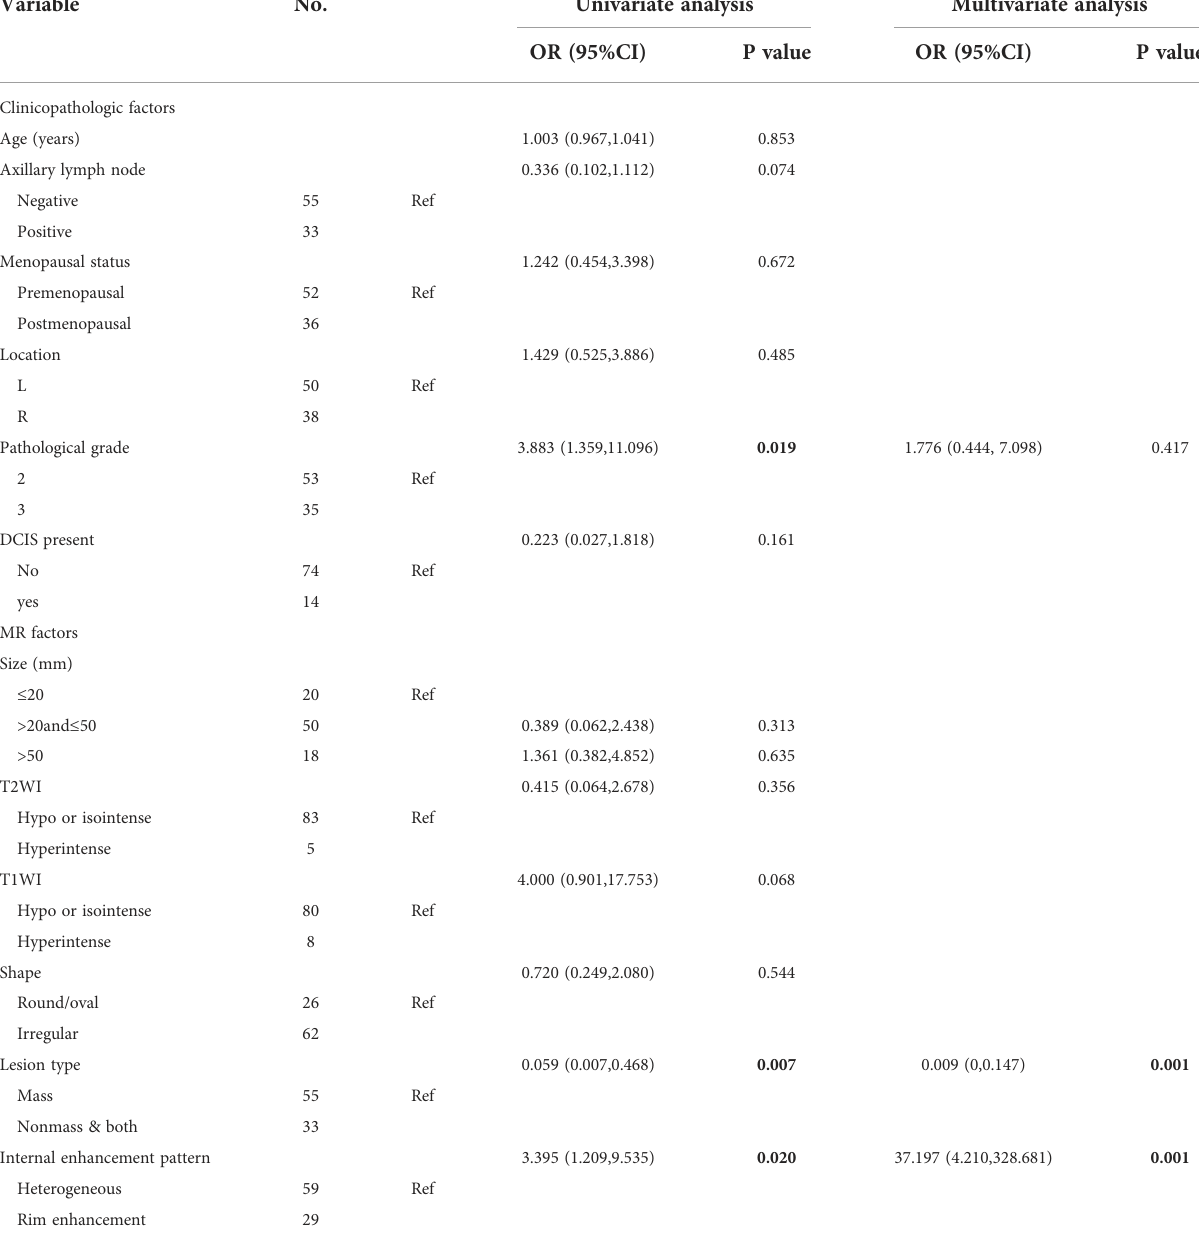
TABLE 4 Univariate and multivariable logistic analysis of clinical, MR and pathological features for predicting TNBC subtypes in the training